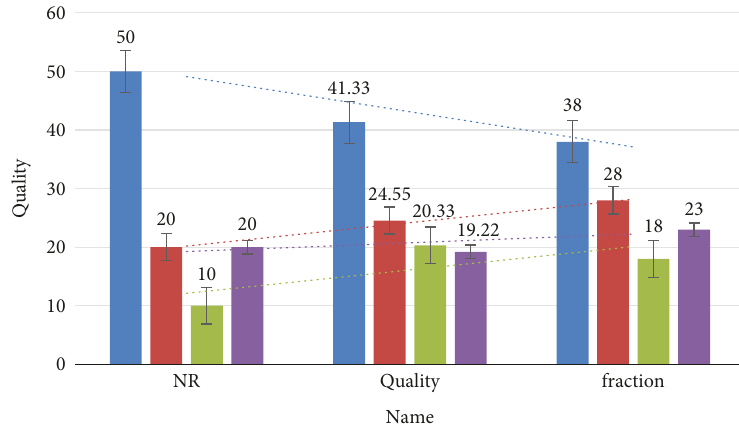
Figure 5: Formulation quality of graphene